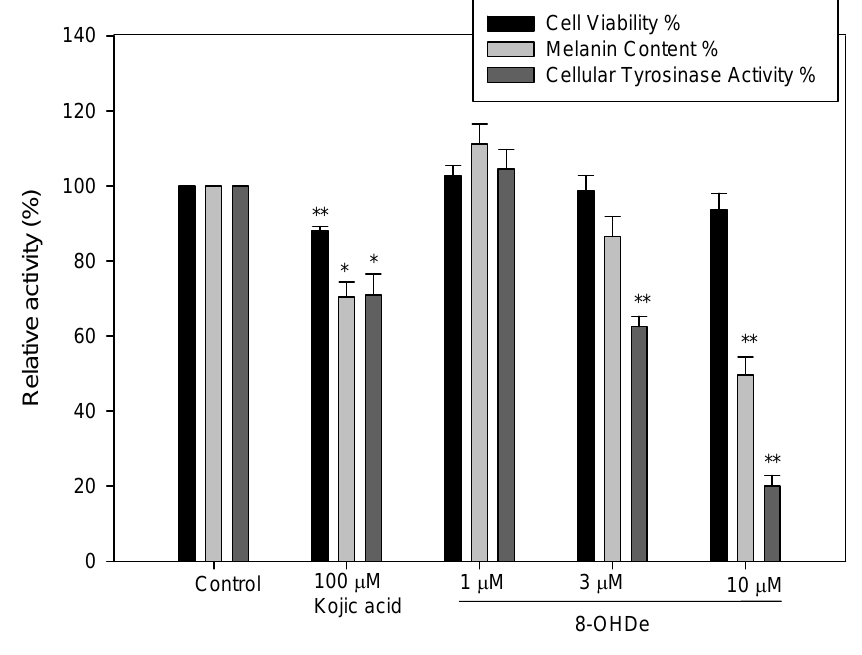
Figure 2. Effects of 8-OHDe on cell viability, melanin content, and cellular tyrosinase activity of mouse B16 melanoma cells. The cells were cultured in 6-well plates and incubated with tested agents for 3 d. Cell viability, cellular tyrosinase activity, and melanin content were assayed as described in the Experimental section. Bars represent the means ± S.D. of three independent experiments. Significant differences were